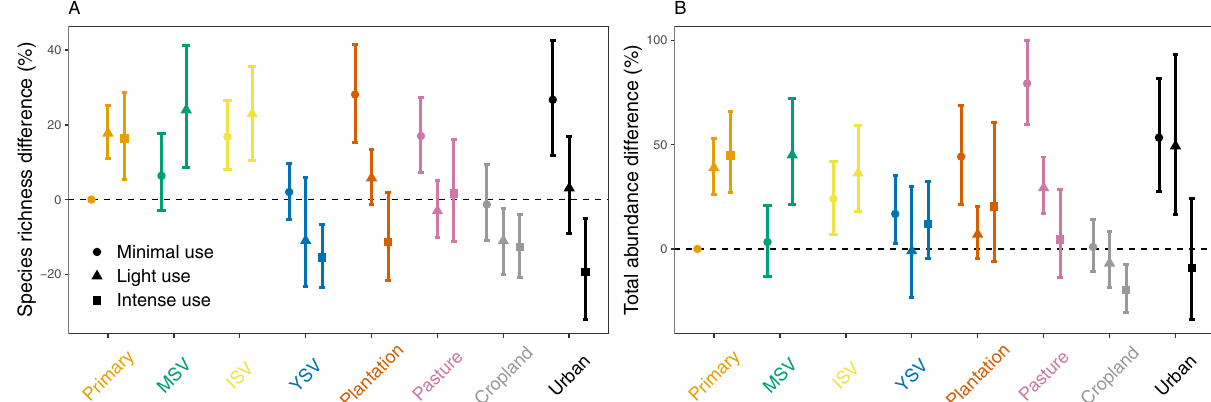
Fig. 2 Responses of pollinator biodiversity to LUI (a combined variable of land-use type and intensity). Each panel represents a linear or generalised linear mixed-effects model for: A species richness; and B total abundance. We excluded Simpson diversity here since AIC was greater for the main model than the intercept-only model. Colours represent land-use type: orange (primary vegetation, Primary), green (mature secondary vegetation, MSV), yellow (intermediate secondary vegetation, ISV), blue (young secondary vegetation, YSV), dark orange (plantation forest, Plantation), pink (Pasture), grey (Cropland), and black (Urban), and point shape represents land-use intensity: circle (minimal use), triangles (light use), and squares (intense use). Effect sizes were adjusted to a percentage by drawing fi xed effects 1000 times based on the variance-covariance matrix, expressing each fi xed effect within each random draw as a percentage of the baseline (primary vegetation minimal use), and then calculating the median value (shown as points) and 2.5th and 97.5th percentiles (shown as error bars). See Supplementary Table 5 for the number of sites and Supplementary Tables 6 and 7 for the model summaries. Source data are provided as a Source Data fi